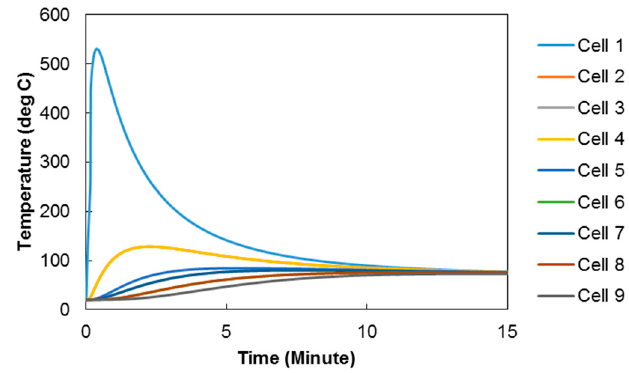
Figure 13. Temperature of cells in the battery module.